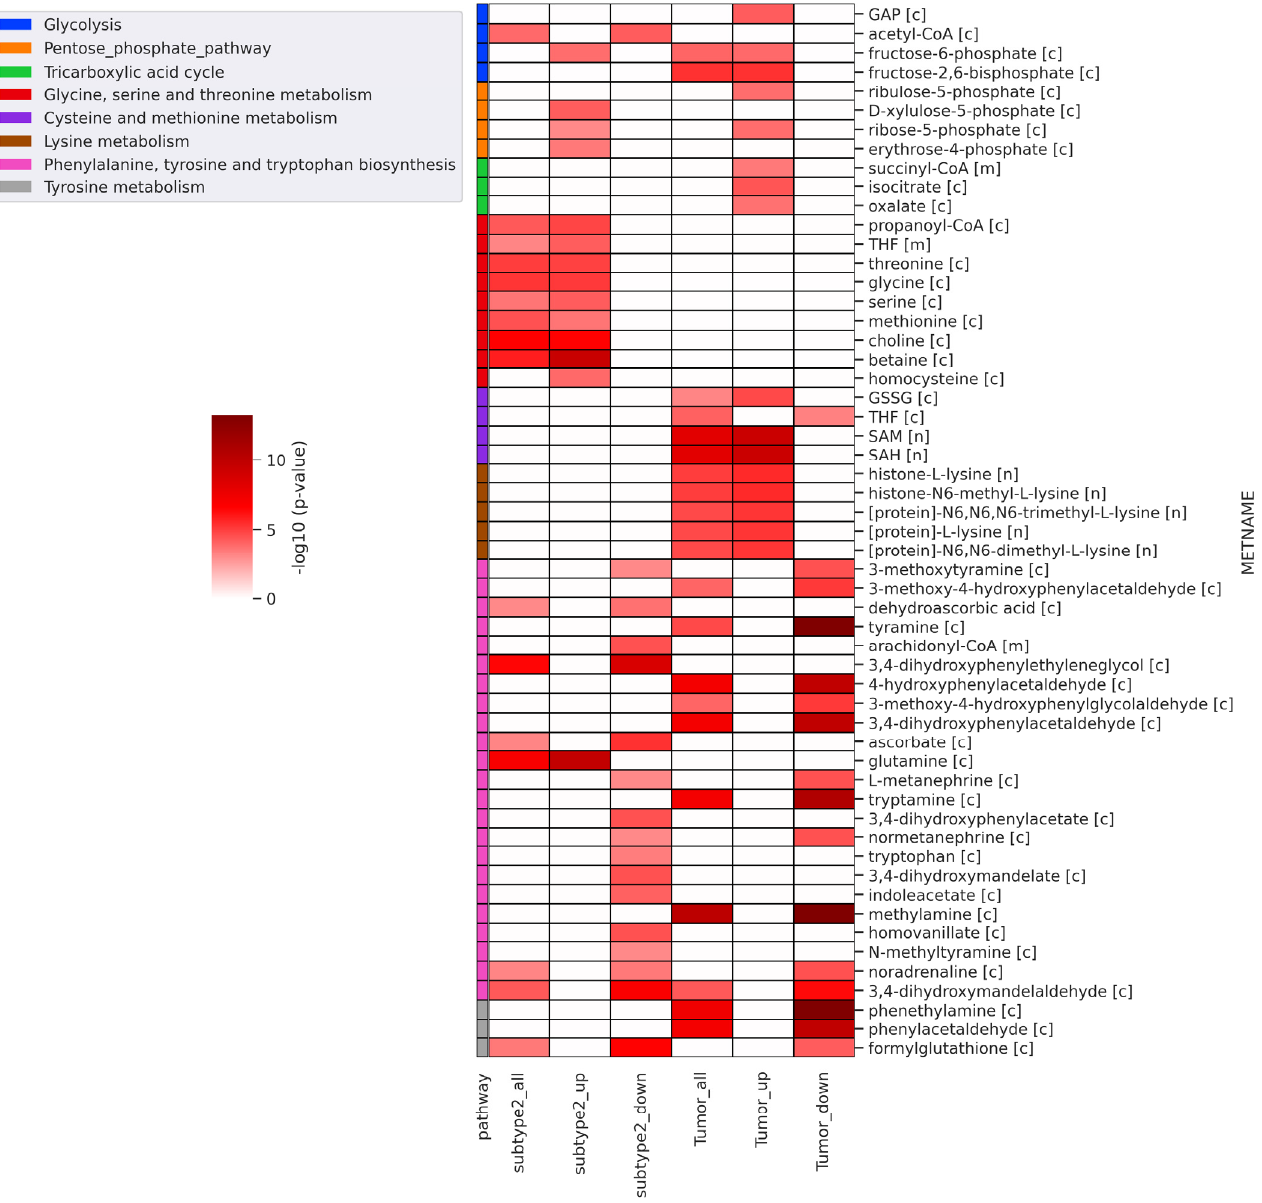
Figure 5. Heatmap of significant reporter metabolites involved in various metabolic pathways ob- tained for different conditions (subtype2_all: all DEGs of metabolic subtype-1 vs. metabolic subtype-2 condition; subtype2_up: upregulated genes in metabolic subtype-1 vs. metabolic subtype-2 condition; subtype2_down: downregulated genes in metabolic subtype-1 vs. metabolic subtype-2 condition; tumor_all: all DEGs of normal vs. tumor conditions; tumor_up: upregulated genes in normal vs. tumor conditions; tumor_down: downregulated genes in normal vs. tumor conditions). The metabolite name (METNAME) also includes the compartment information: [c]—cytosol, [m]—mitochondria, [n]—nucleus.